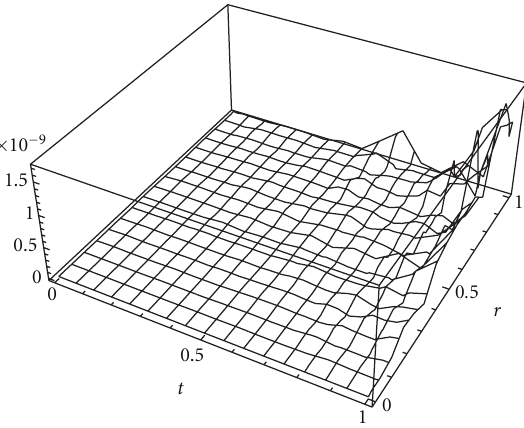
( t , r ) for (cid:2) = − 0 . 15